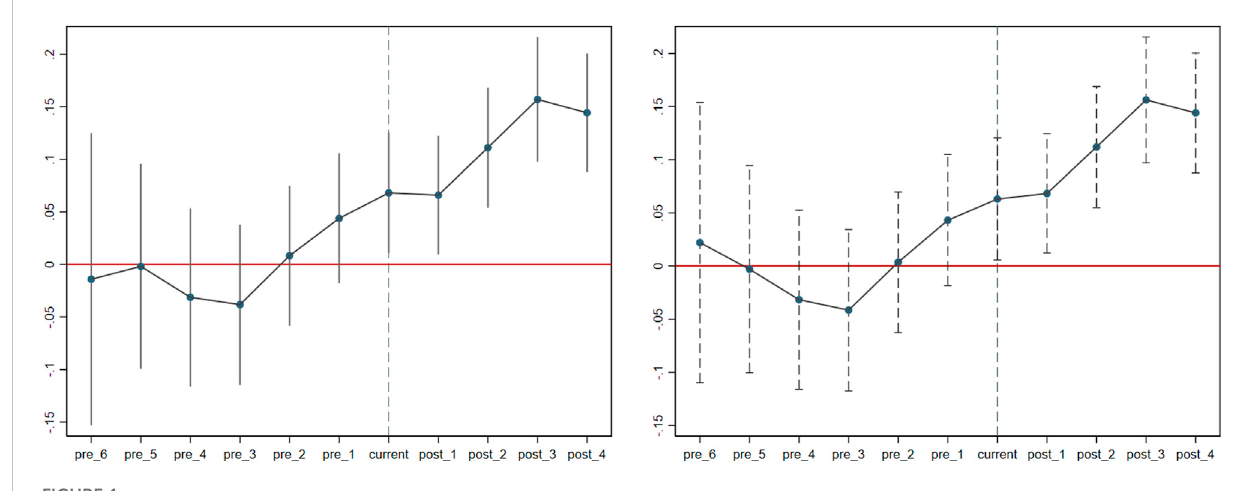
FIGURE 1 The dynamic impact of ESG policy on green innovation.